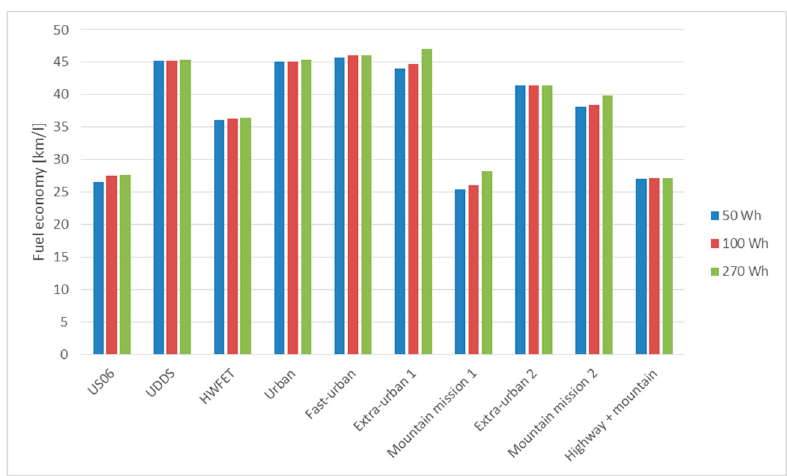
Figure 19. Fuel economy as a function of BZ sizing, diesel engine.